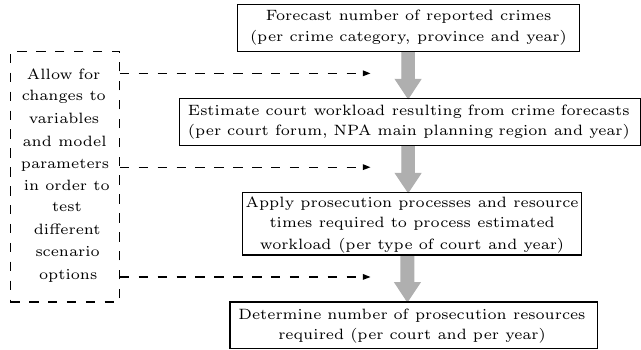
Figure 1: A schematic representation of the selected overall modelling